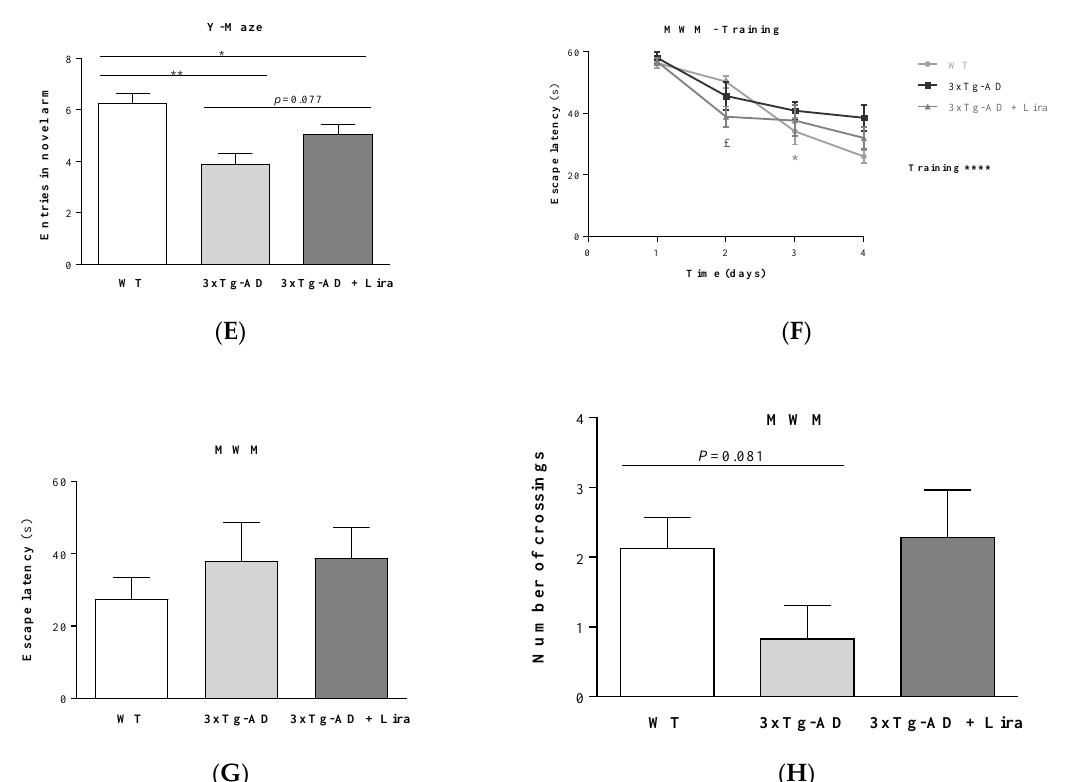
Figure 2. Effect of liraglutide on behavioral performance in female mice with early AD-like pathology. Total distance travelled ( A ), and distance travelled ( B ) and time spent in the center ( C ) of the open field area during the open field test; time spent in start arm during training ( D ) and number of entries into the novel arm during testing session ( E ) in the Y-maze test; escape latency across trainings days ( F ) and testing session ( G ), and the number of crossings during testing session ( H ) of the Morris Water Maze test were assessed. Data are the mean ± SE from 6–10 mice/group. Statistical significance: * p < 0.05 or ** p < 0.01, by the one-way ANOVA with the Fisher LSD post-hoc test for multiple comparisons (for a Gaussian distribution: A,B,D,E), or by the non-parametric Mann-Whitney test (for a non-Gaussian distribution: C,G,H). Regarding Figure 2F, statistical significance: * p < 0.05 in WT day 3 vs. WT day